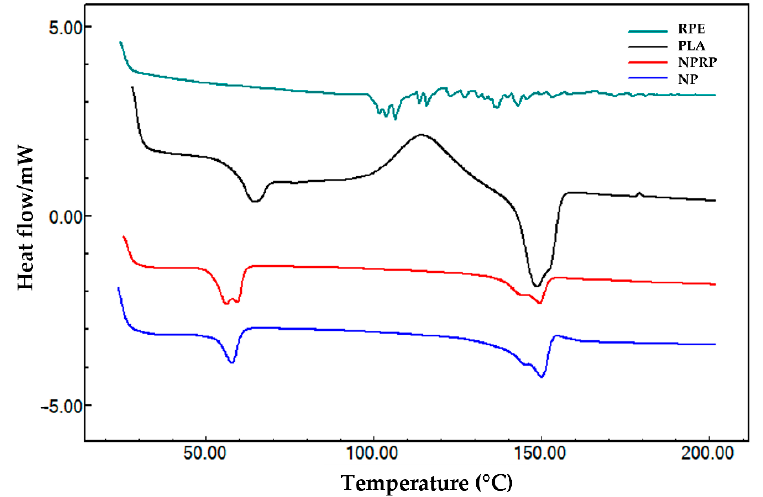
Figure 4. DSC curves of red propolis extract (RPE), PLA, nanoparticles loaded with red propolis (NPRP), and nanoparticles without red propolis (NPs).